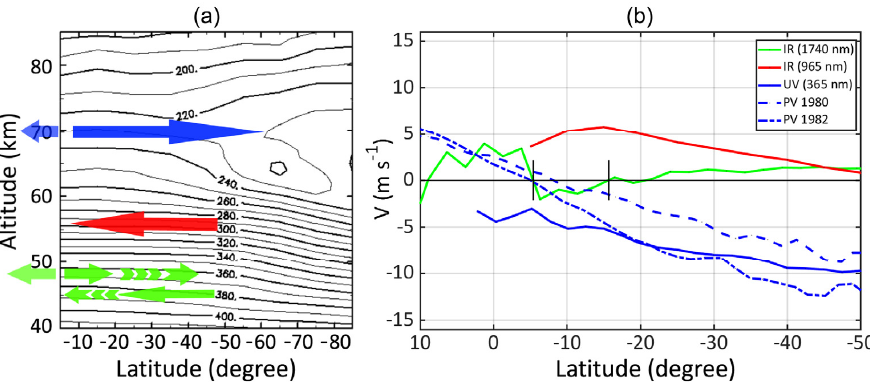
Figure 11. ( a ) Mean direction of the meridional wind at different altitudes (arrows) overlaid on the thermal structure of the atmosphere in latitude-altitude coordinates from combined Venus Express and Akatsuki radio occultation experiment results, averaged over both hemispheres [30]. We changed the latitude sign to negative to adopt the figure to the Southern hemisphere. Numbers at the contours indicate the temperature in Kelvin. Latitudes represent both hemispheres assuming north-south symmetry. The thermal structure is used for illustration to designate different levels in the Southern Hemisphere. Blue arrows represent UV cloud tracking results (PV and VMC/VEX), red arrow: IR cloud tracking from VMC/VEX, green arrows: 1.74 µm (1740 nm) IR cloud tracking from VIRTIS/VEX. Dashed green arrows indicate branches of Hadley cells that are not observable in the experiment. ( b ) Mean latitudinal profiles of the meridional wind from several experiments; line colors correspond with those in ( a ), line types correspond with the legend. Two vertical lines located at v = 0 axis limit the latitude range of the 1.74 µm cloud tracking profile (green line) where the meridional wind becomes south-poleward.